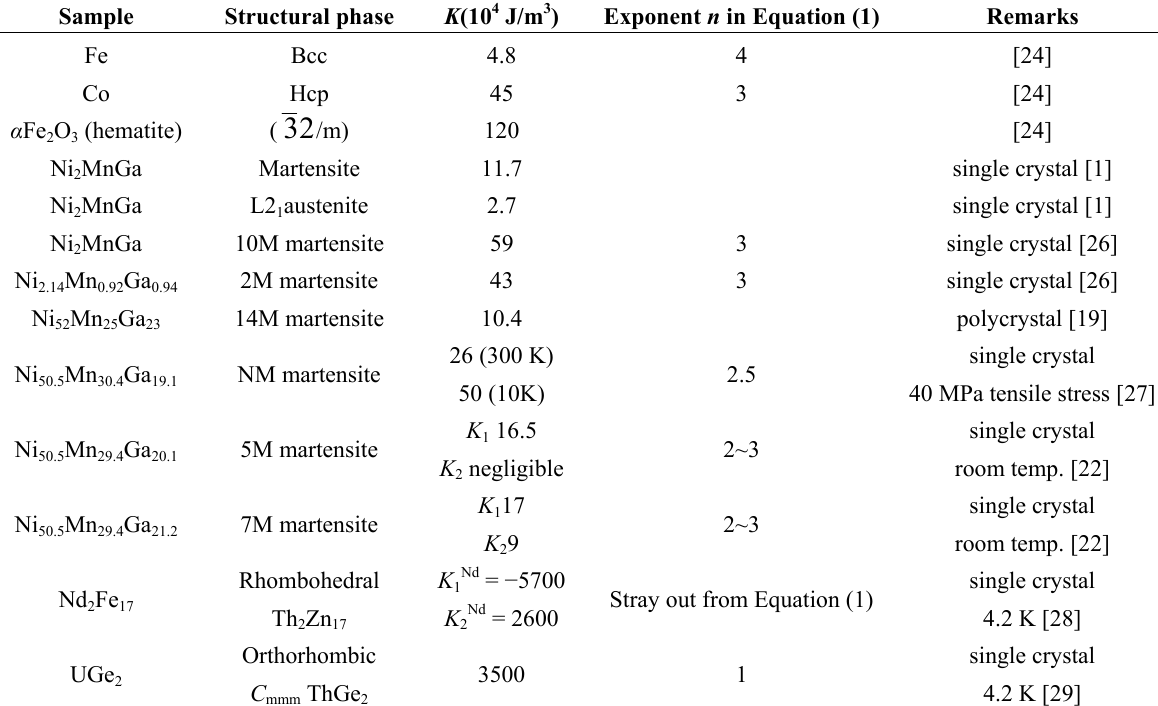
Table 1. Magnetocrystalline anisotropy constant K and temperature dependence of K.